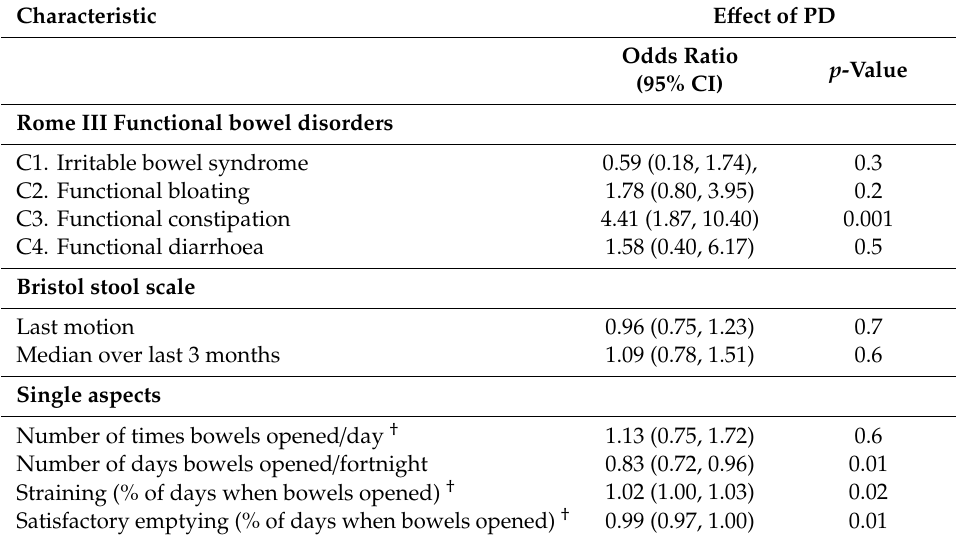
Table 2b. Evaluation of responses to questionnaires on bowel function in predicting PD status. Table 3. Evaluation of responses to questionnaires on bowel function in predicting PD